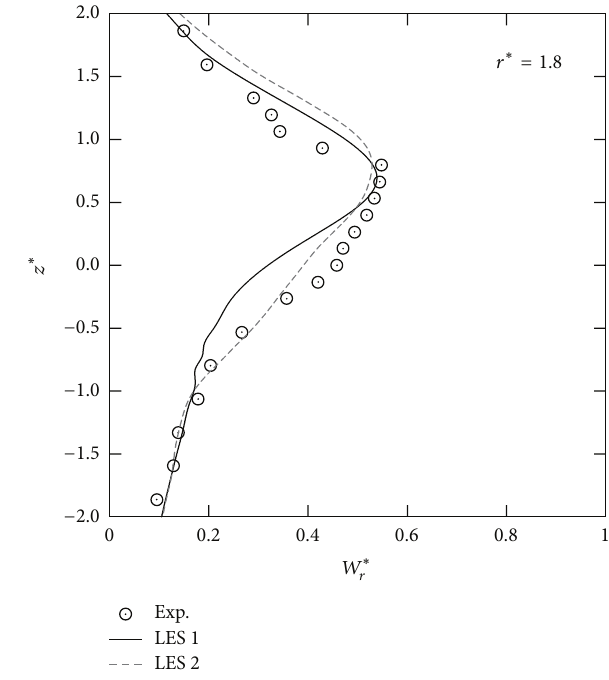
Figure 9: Radial component of the ensemble-averaged mean velocity at 𝑟 ∗ = 1.8 .